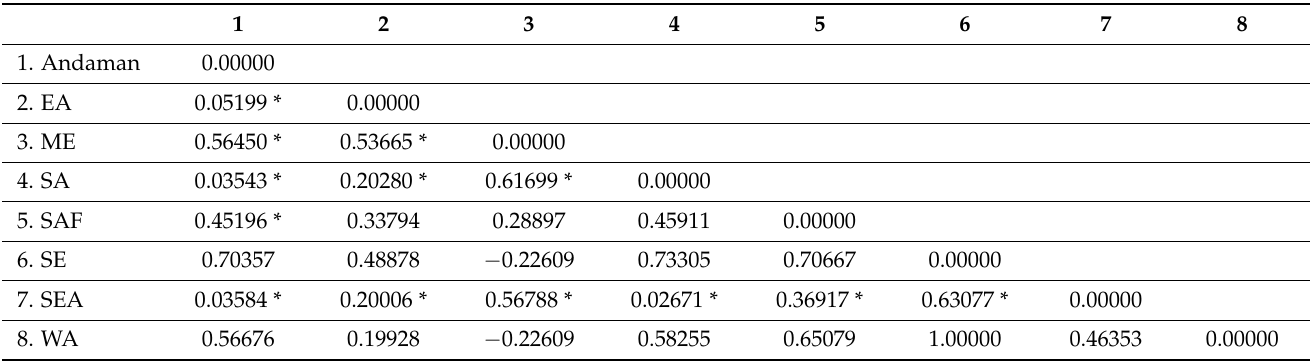
Table 2. Pairwise FST values of haplogroup B goats of Andaman and other different regions.